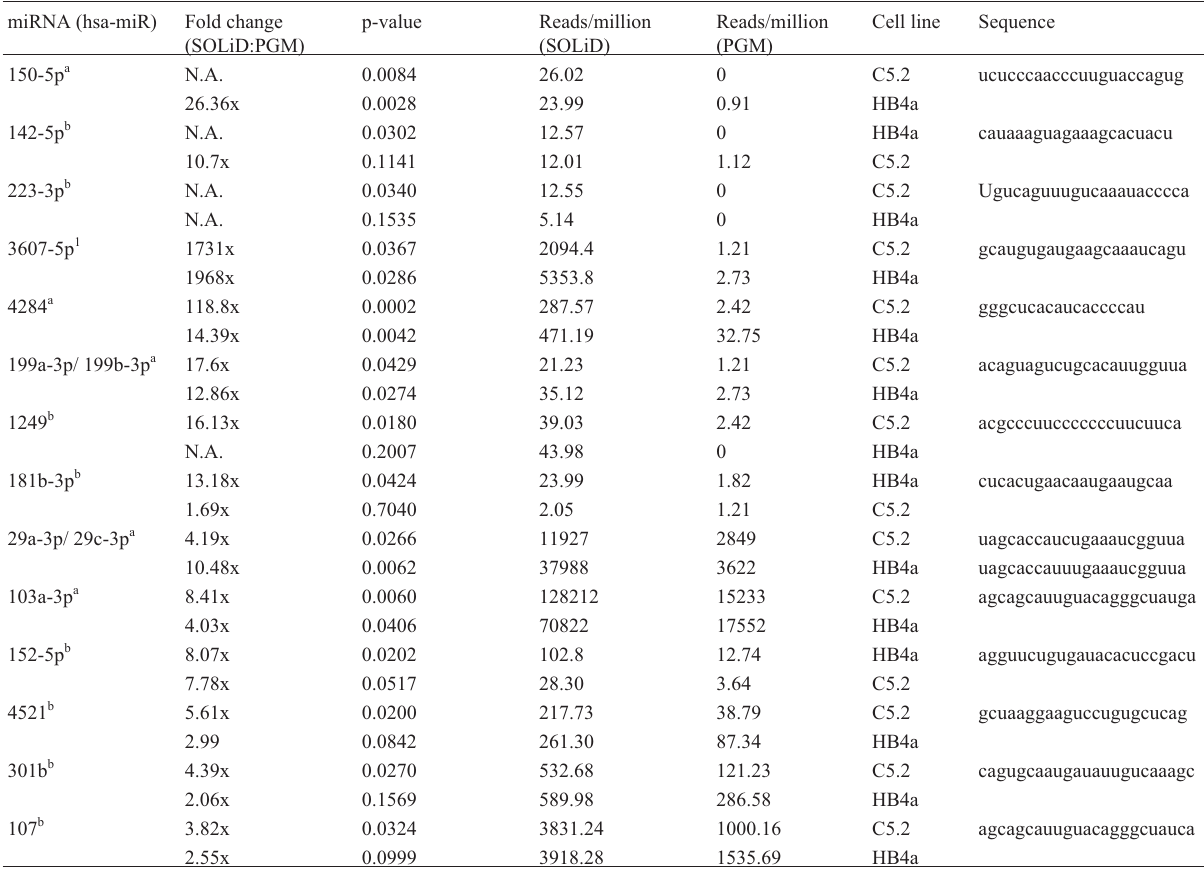
Table 2 - miRNAs more abundantly detected by the SOLiD